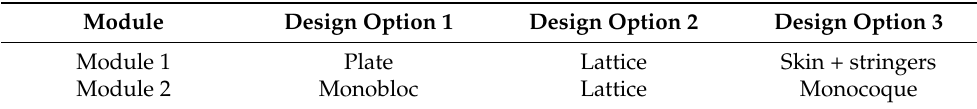
Table 2. Morphological matrix for the construction of different concepts of the base.